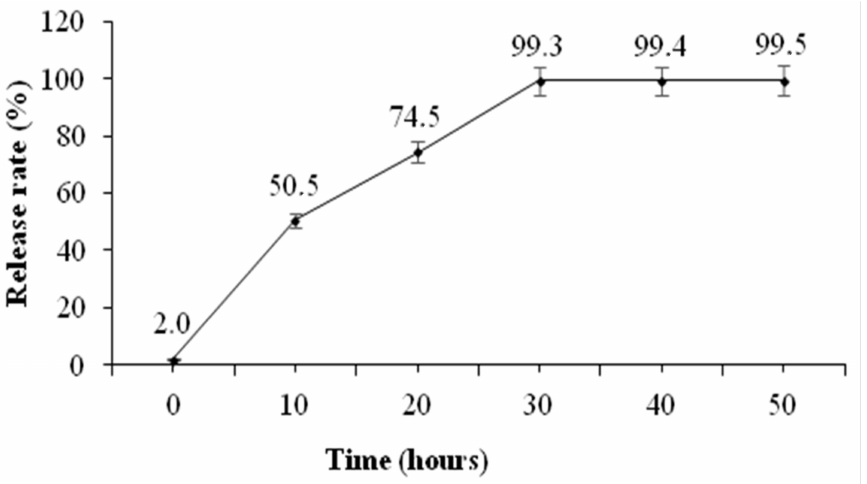
Figure 5. Mean ( ± S.E.M.) percentage of over-time release of gonadotropin-releasing hormone (GnRH) from GnRH-loaded chitosan